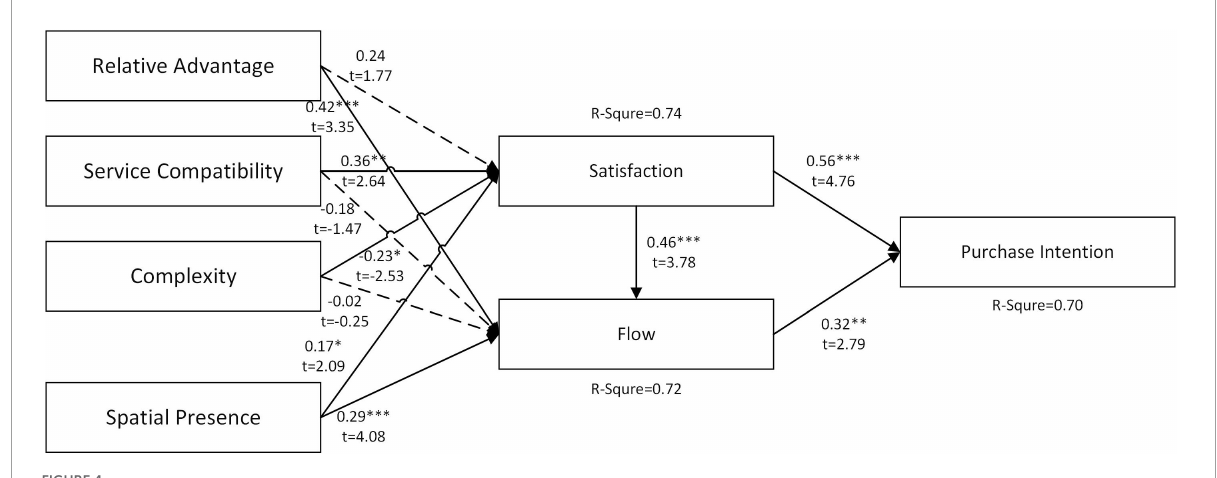
FIGURE4 Results for women samples. *** P < 0.001, ** P < 0.01, * P < 0.05, ns – not